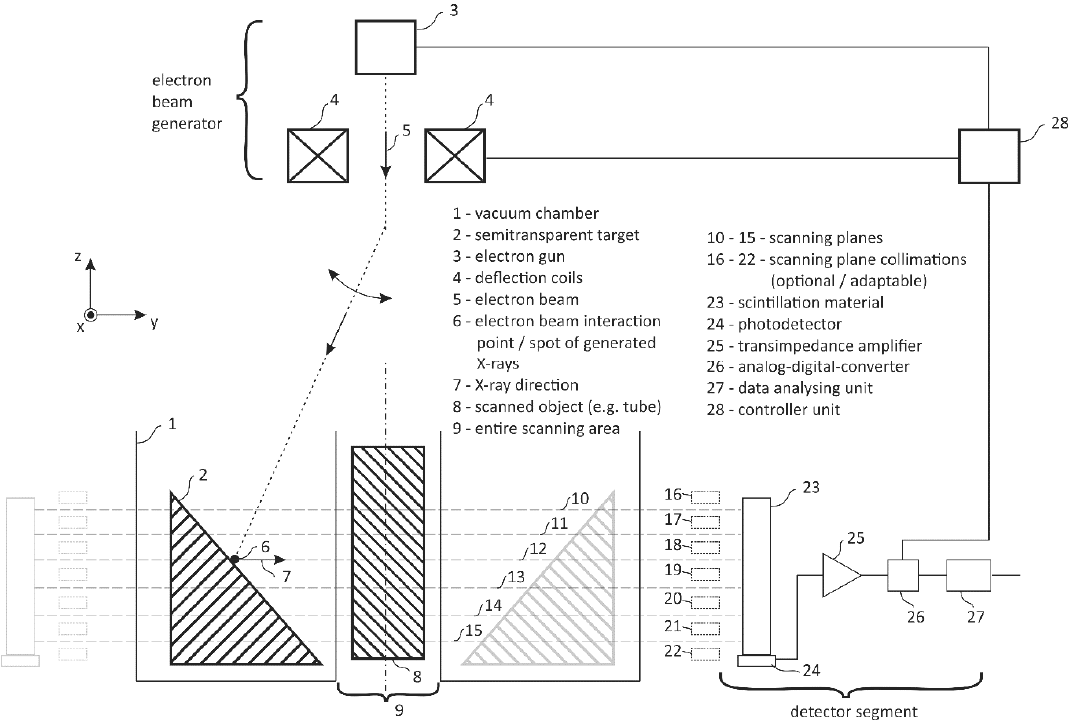
Figure 4. Principle sketch of a prospective multi-plane UFXCT using a certain number of circularly stackable single scintillation detectors extended over a certain CT scanning height.